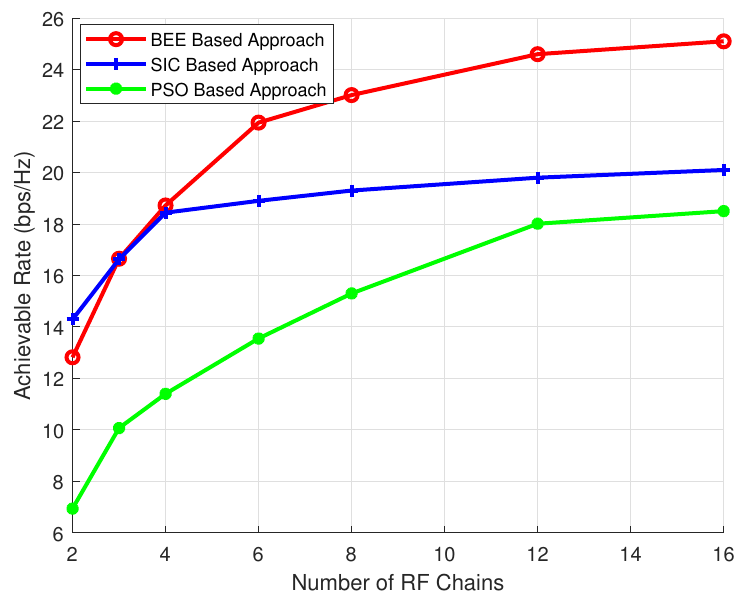
Figure 9. Simulation for varying number of RF